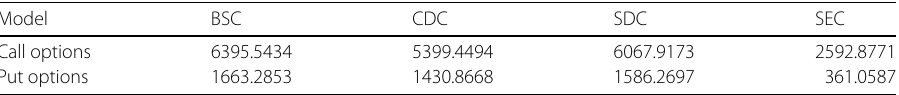
Table 3 Mean squared errors of call option prices obtained by four different models for the Russell 2000 option prices Model